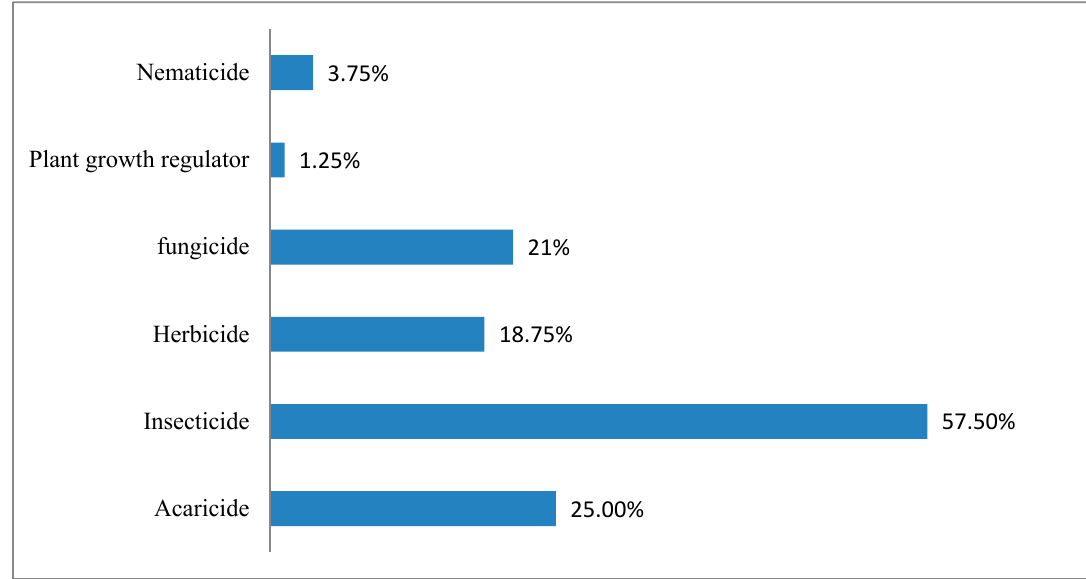
Figure 5. Distribution of selected pesticides according to usage.